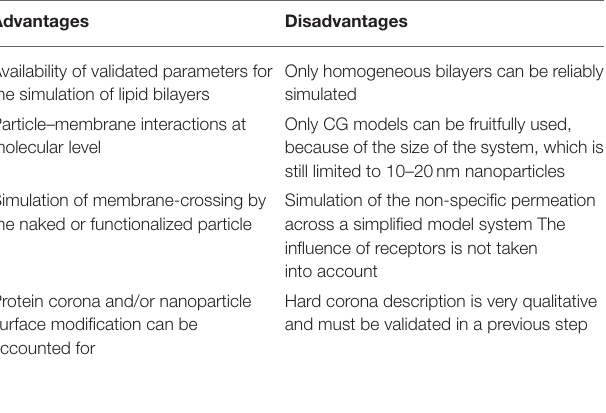
TABLE 4 | Advantages and disadvantages for nanoparticle–cellular membrane